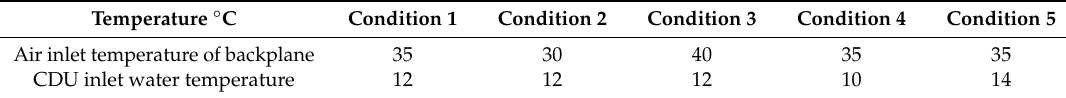
Table 3. Di ff erent temperature Table 3. Different temperature conditions.